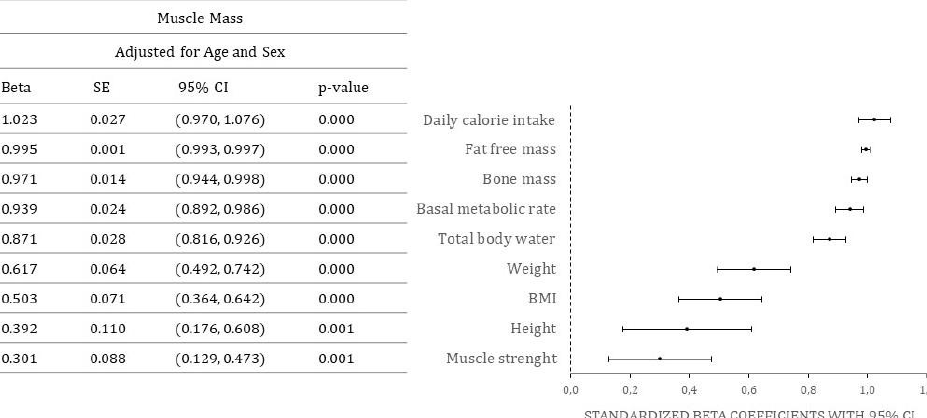
Figure 2. Predictors of muscle mass. Abbreviations: SE-standard error, CI-confidence interval, body mass index (kg/m 2 ), CI-confidence interval.